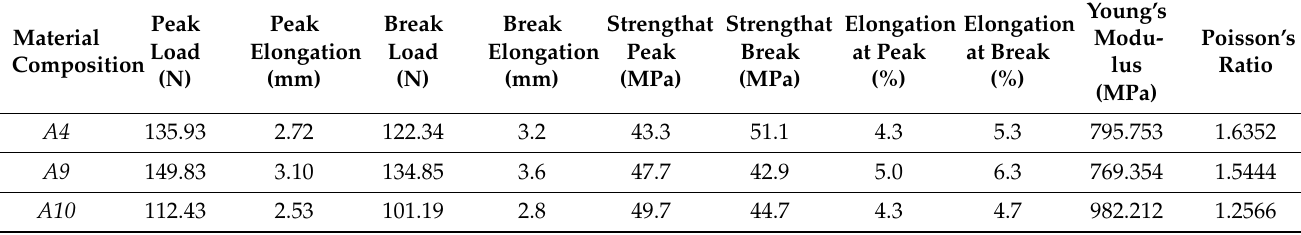
Table 7. Tensile testing of A copper and ABS at different proportions.